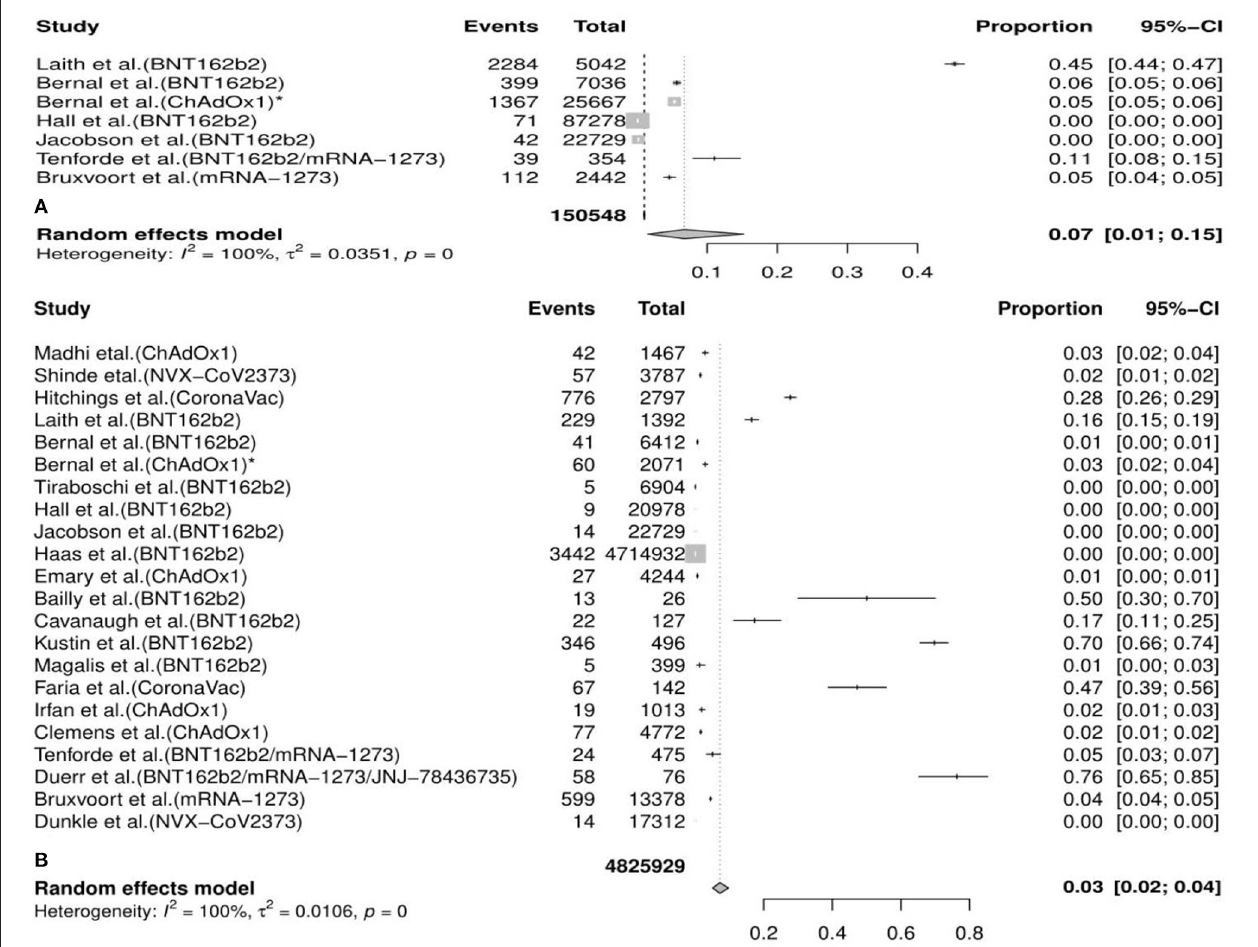
FIGURE 2 | Meta-analysis for the overall incidence of various COVID-19 variants post first vaccine (A) and post second vaccine (B) .* indicates the second arm in the study of Bernal et al. CI, confidence